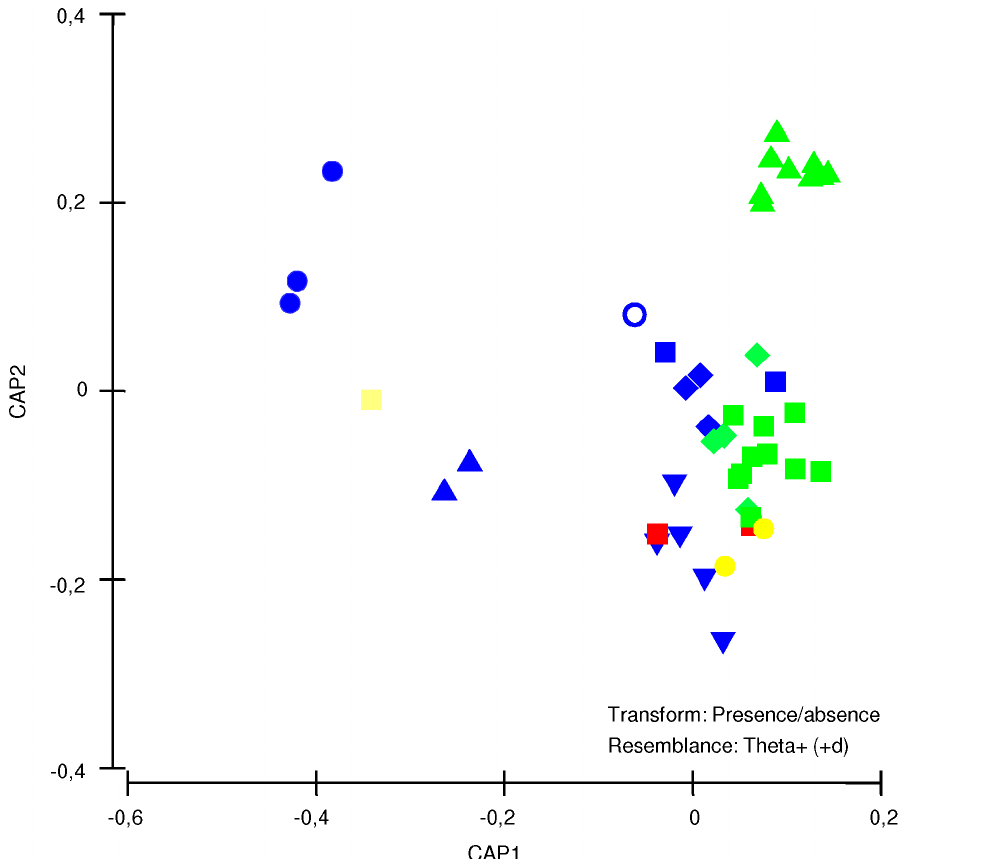
Figure 6. Canonical analysis of principal coordinates (CAP) plots generated from taxonomic dissimilarity coefficients (theta) of the biological data matrix, using LMEs as predictor factor. Blue circle=Benguela Current, Blue triangle=Celtic-Biscay Shelf, Yellow square=Agulhas Current, Hollow blue circle=Scotian Shelf, Inverted blue triangle=Caribbean Sea, Green Triangle=Gulf of Alaska, Blue square=Patagonian Shelf, Yellow circle=Antarctic, Red square=Mediterranean Sea, Blue diamond=Northeast US Continental Shelf, Green square=Beaufort Sea, Green diamond=Kuroshio Current.